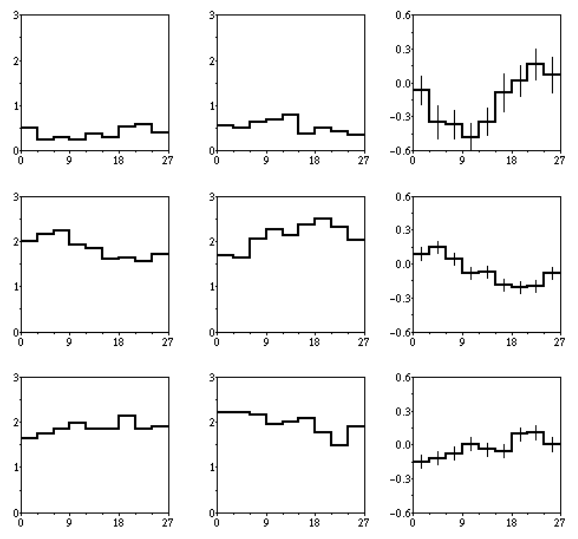
Fig. 2. Superposed epoch distribution of east-west asymmetry for three periods of time: July 1996–December 1997 (top panels), 1999–Jun 2001 (middle panels), 2002–2003 (bottom panels). The left and middle panels show distributions of the CME occurrence rate (per day) for the eastern (left) and the western (middle) limb. The right panels show distribution of the asymmetry index. The distributions are calculated in 3-day bins, corresponding to 40 ◦ lon- gitudinal zones. The error bars represent 1 σ statistical